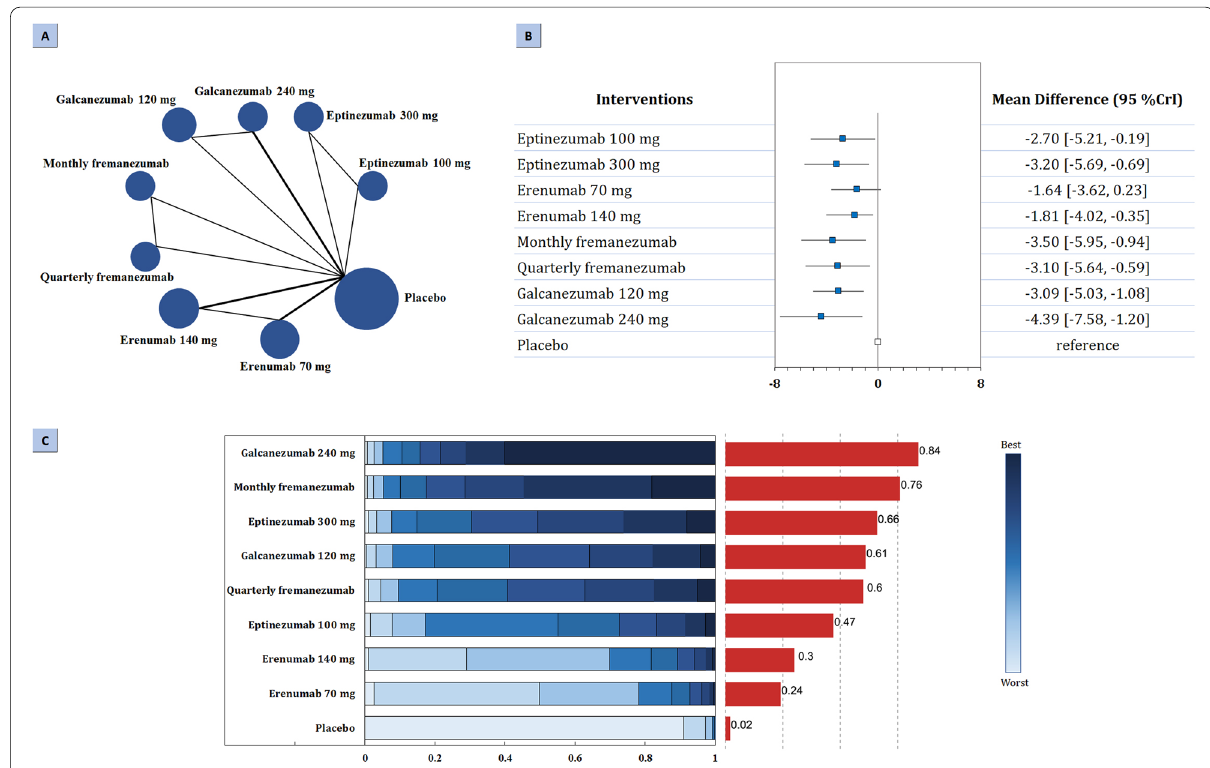
Fig. 1 Summary of the primary efficacy outcome. A Network plot of change in MMDs. The width of the lines is proportional to the number of studies comparing every pair of treatments, and the size of each circle is proportional to the number of participants. B The forest plot shows the risk ratio (RR) and credible interval (CrI). C Ranking probabilities graph (blue bars) of each treatment agent. The SUCRA values (red bars) for each treatment are as follows: 84% for galcanezumab 240 mg; 76% for monthly fremanezumab; 66% for eptinezumab 300 mg; 61% for galcanezumab 120 mg; 60% for quarterly fremanezumab; 47% for eptinezumab 100 mg; 30% for erenumab 140 mg; 24% for erenumab 70 mg; 2% for placebo.